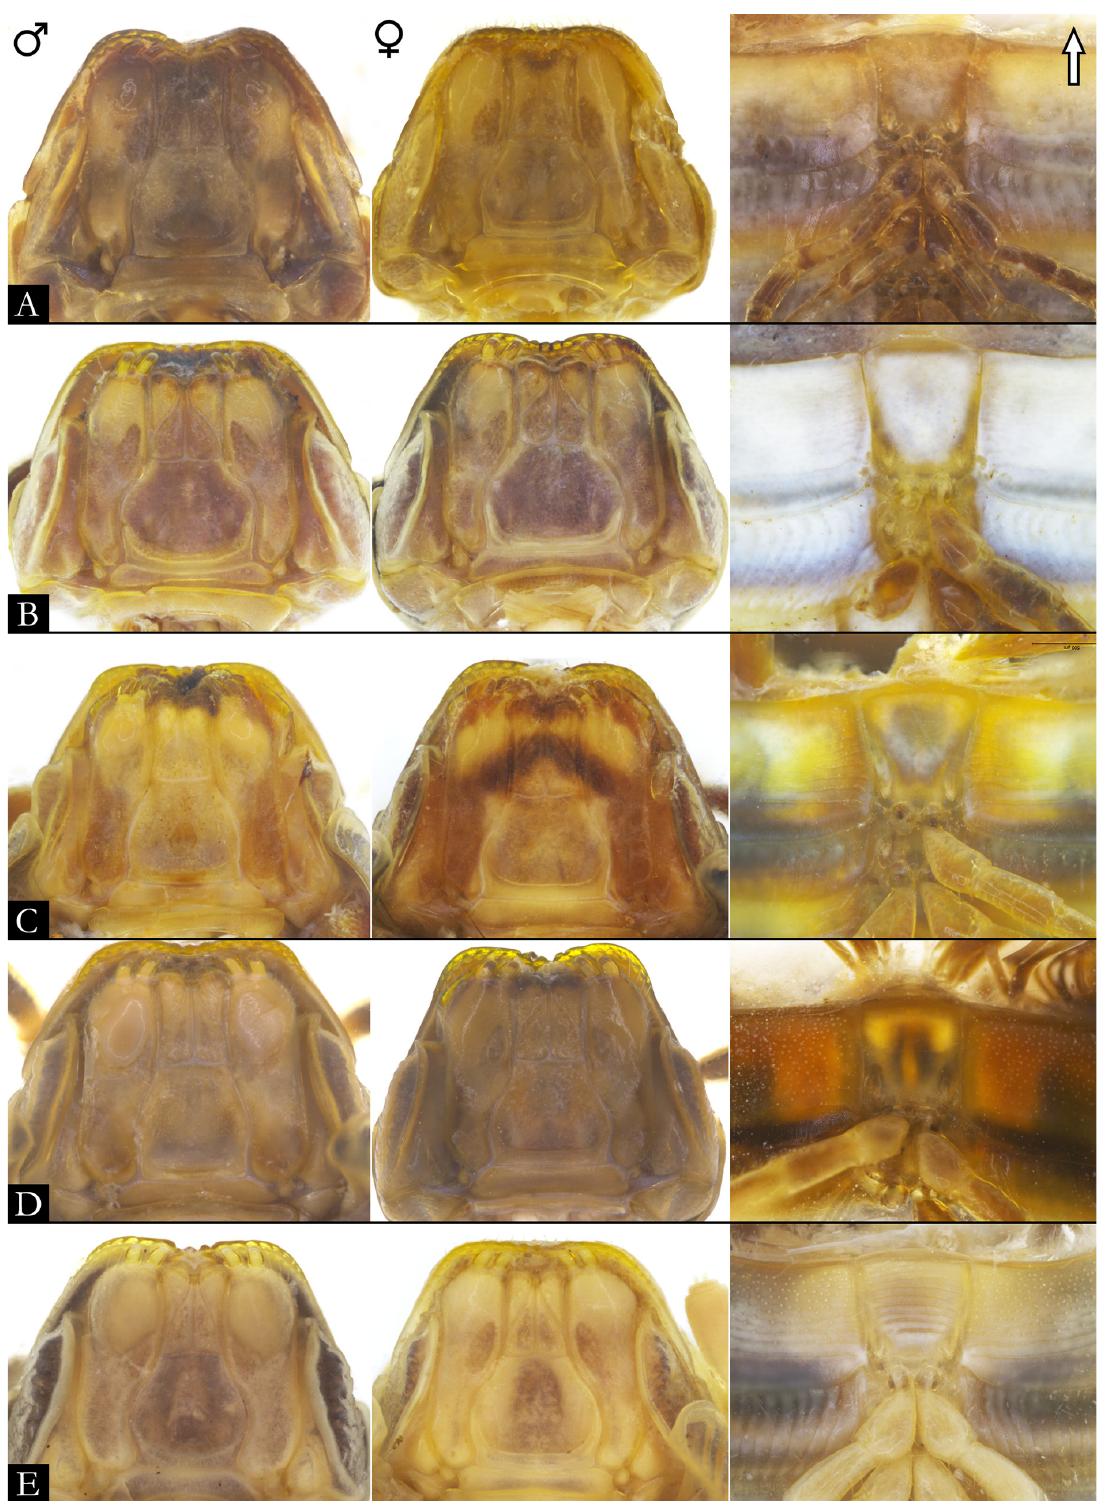
Fig. 168. Stereoscopic images of gnathochilarium and anterior sternum of species of